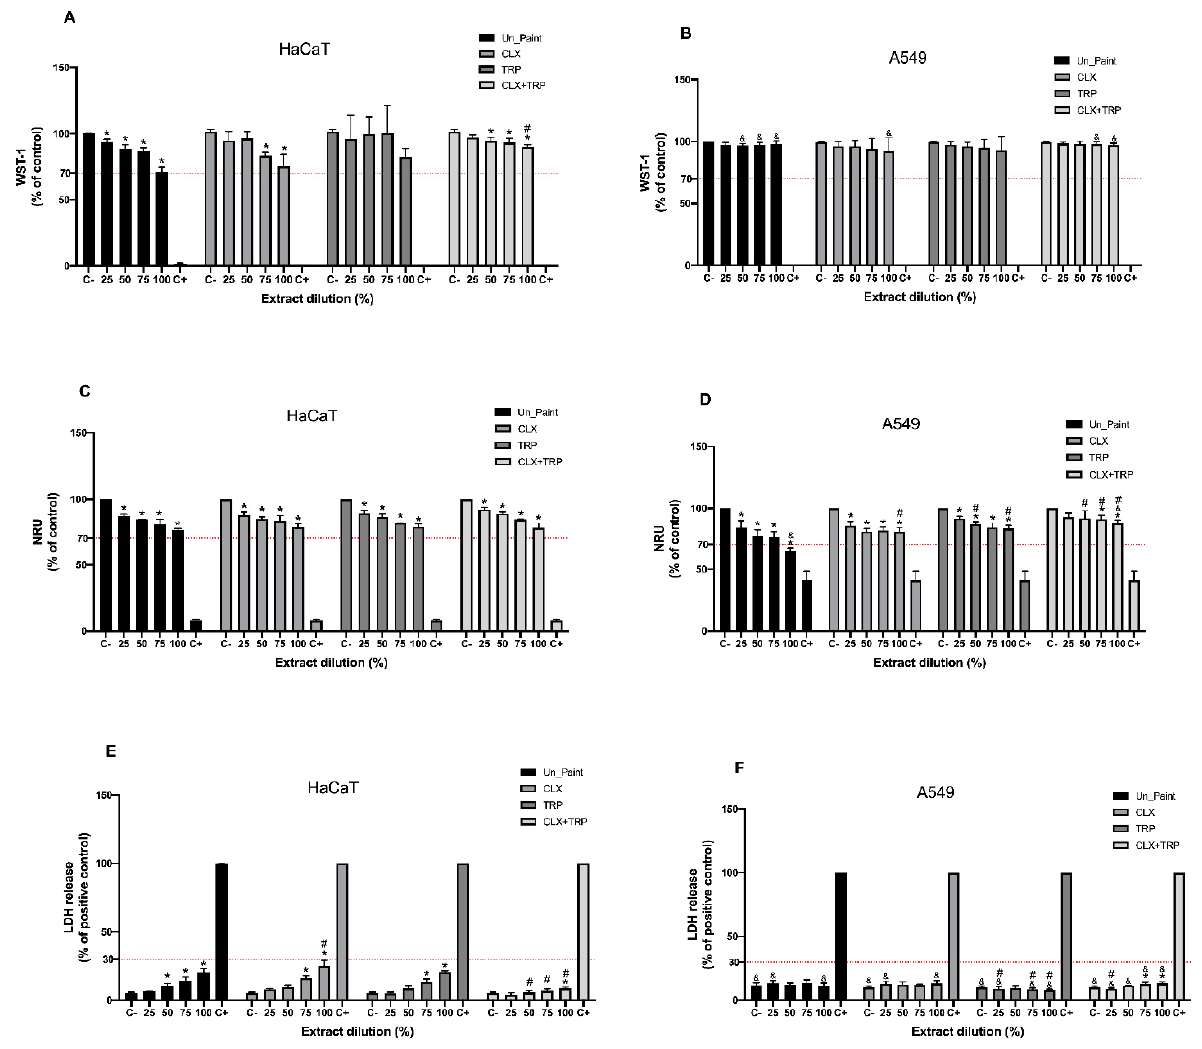
Figure 5. Results of WST-1 ( A , B ), NRU ( C , D ), and LDH ( E , F ) assays, with HaCaT and A549 cells, after 24 h incubation with Un_Paint, CLX, TRP, and CLX+TRP extracts at concentration of 25%, 50%, 75%, and 100%. C − negative control (assay medium), C+ positive control (Triton X-100 solution (1%) for WST-1 and LDH, or SLS 0.2 mg/mL solution of NRU). The red lines represent the defined thresholds of acceptable values for each parameter, 70% for cellular viability and 30% for LDH leakage. The values are expressed as mean ± standard deviation. The statistical significance of the extracts compared to C − is represented by * (One-way ANOVA; p < 0.05) and the statistical differences compared to Un_Paint are represented by # (Two-way ANOVA; p < 0.05). The statistical significance of the extract on A549 cells compared to the same extract, in the same concentration, on HaCaT cells is represented by & (Two-way ANOVA; p < 0.05).